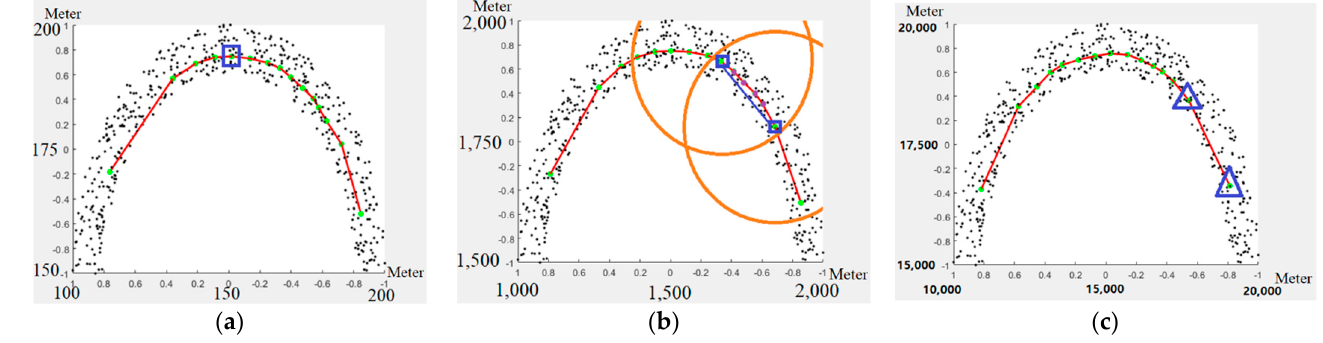
Figure 9. ( a ). Extracted skeleton for network size 100 m × 50 m; ( b ) size 1000 m × 500 m; ( c ) 10,000 m × 5000 m.